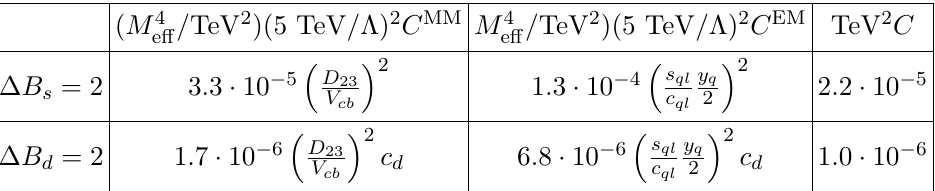
Table 5 . Predictions for the coe(cid:14)cients in the relevant e(cid:11)ective Lagrangians, as de(cid:12)ned in the text, compared with the current bounds in the last column